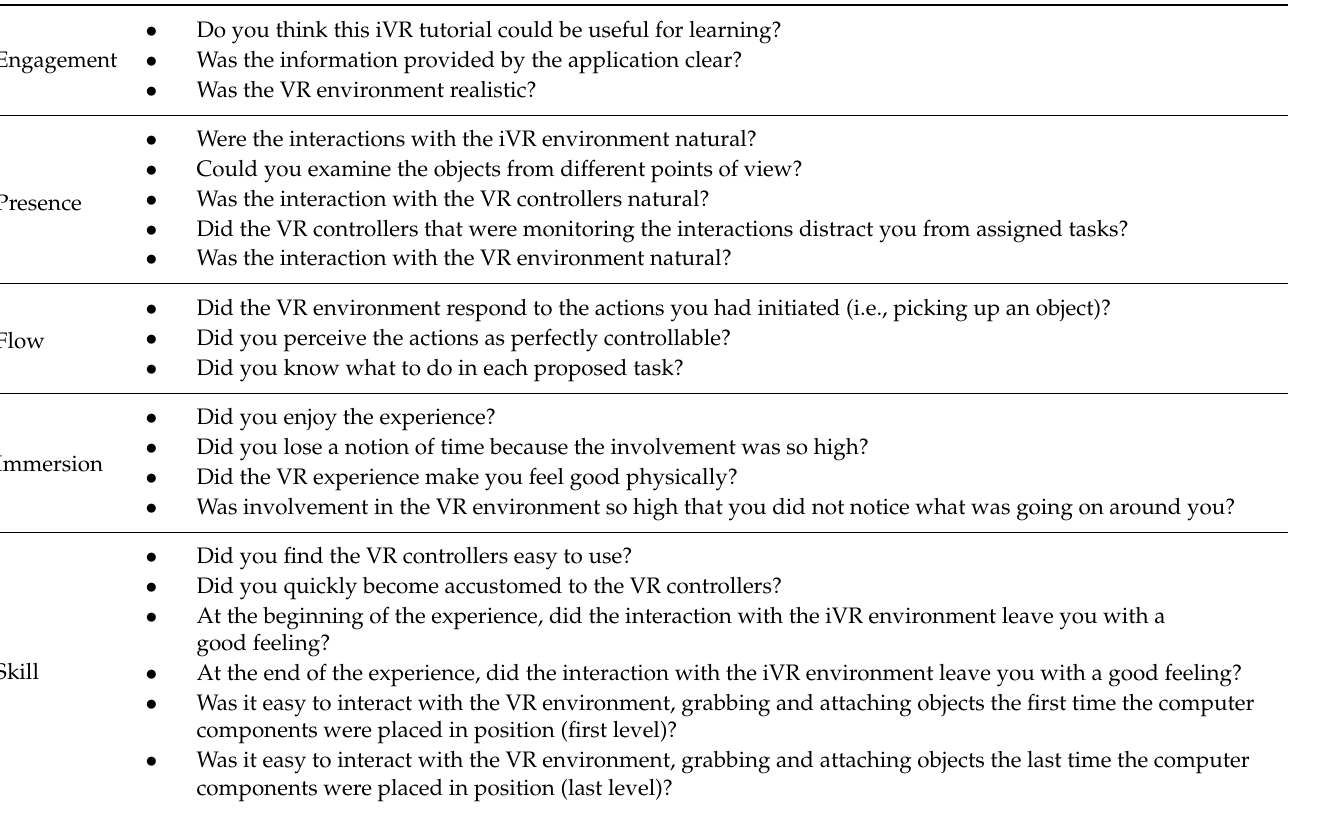
Table 1. Usability and satisfaction survey questions to evaluate the 5 components: engagement, presence, flow, immersion, and